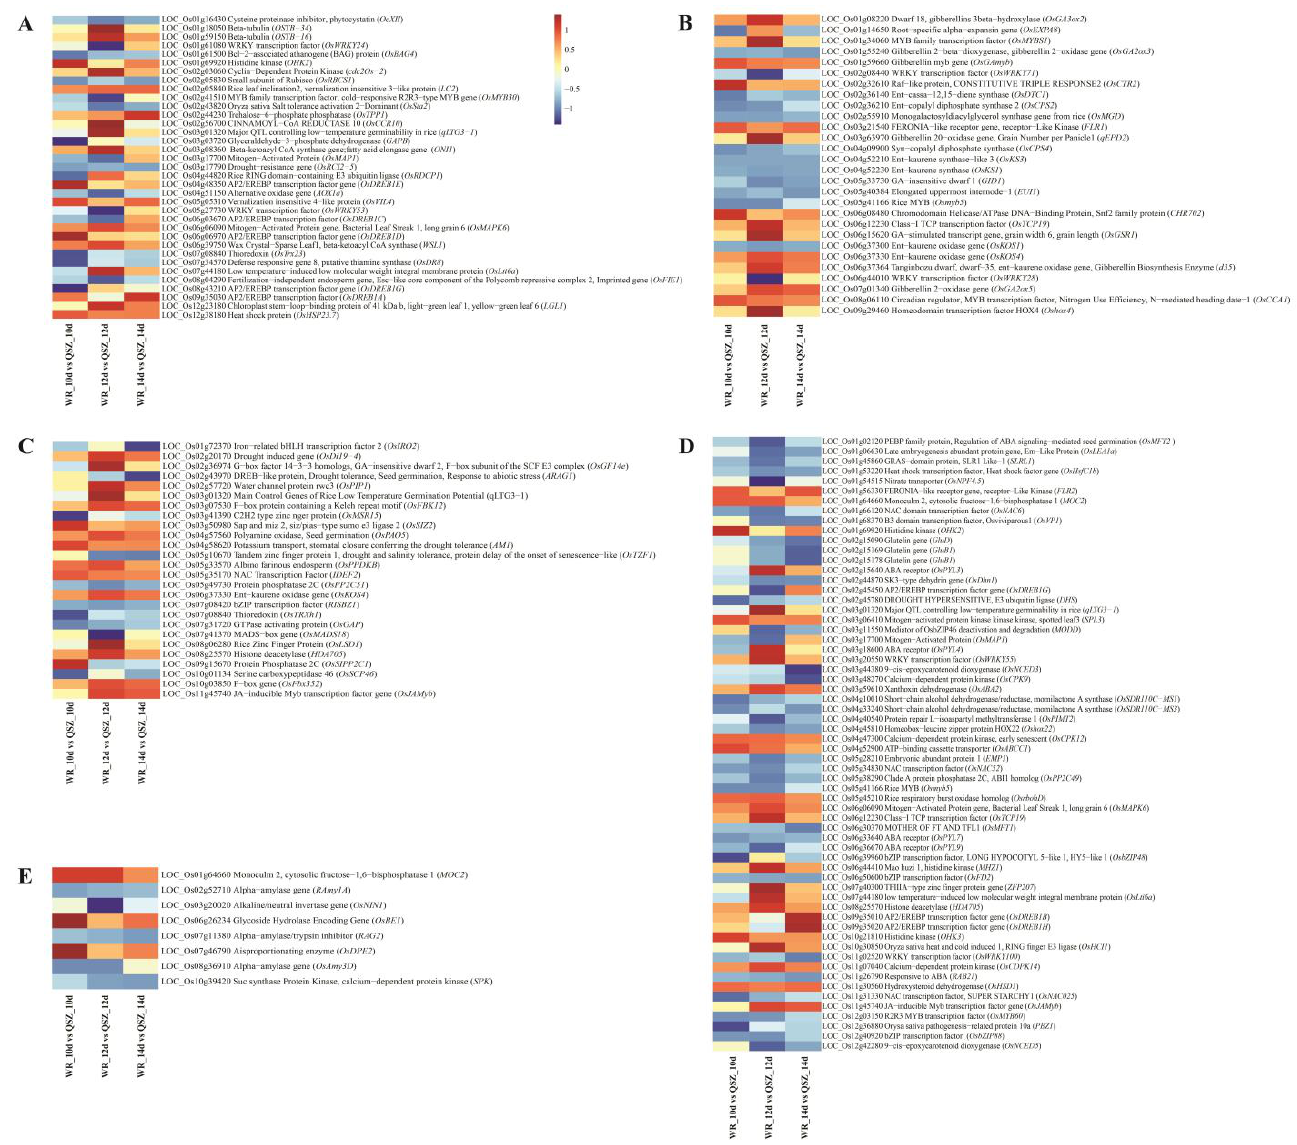
Figure 4. Heat maps of representative DEGs of different catalogs. ( A ) DEGs related to cold. ( B ) DEGs related to GA. ( C ) DEGs related to seed germination. ( D ) DEGs related to ABA. ( E ) DEGs related to α -amylase. The log 2 fold change values of WR04-6 vs. QSZ at respective time points were used to create the heatmap. Red represents the up-regulated gene of WR04-6, and blue represents the down-regulated gene of WR04-6. The color depth indicates the degree of up and down.